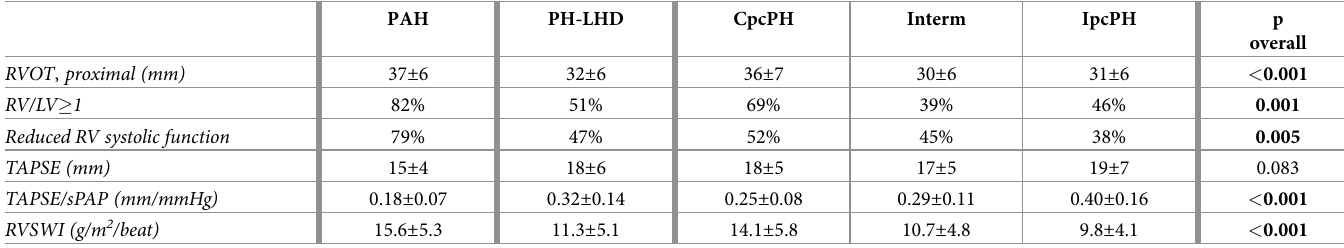
Table 4. Right ventricular function in the different haemodynamic